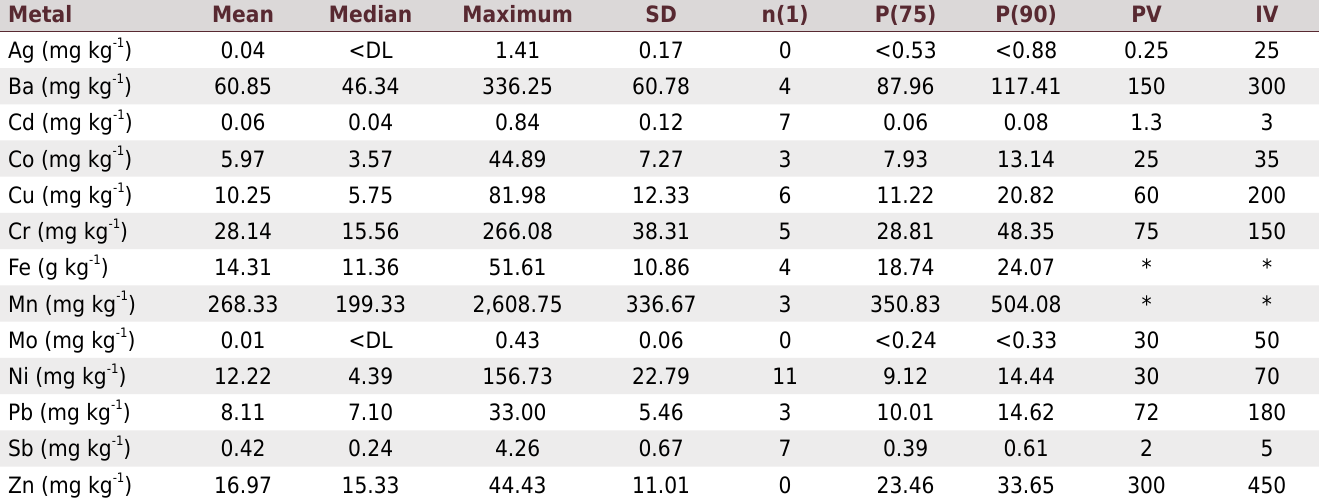
Table 4. Background concentrations (Mean, Median, and Maximum values) and quality reference values (QRVs) for heavy metals in soils of Paraíba state, and prevention and investigation values based on Conama (2009) Metal Mean Median